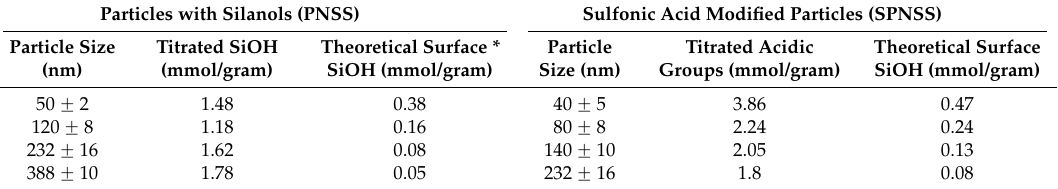
Table 1. The impact of surface modification on the Ion Exchange Capacities (IECs) of Stöber silica nanoparticles. Particle size was measured by dynamic light scattering (DLS) and IECs were determined by